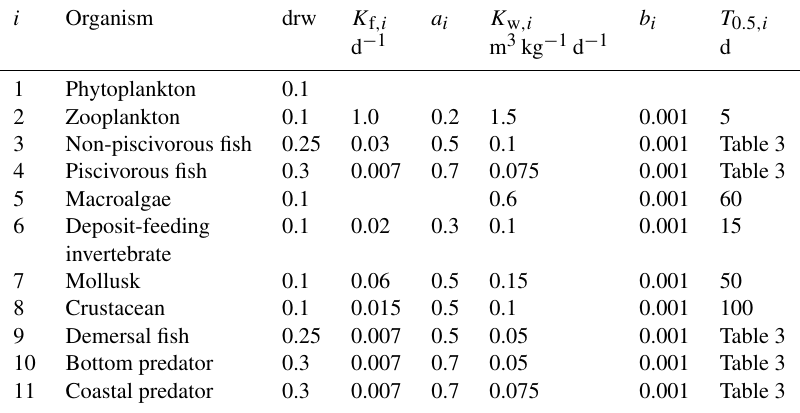
Table 1. Parameters of dynamic food chain model